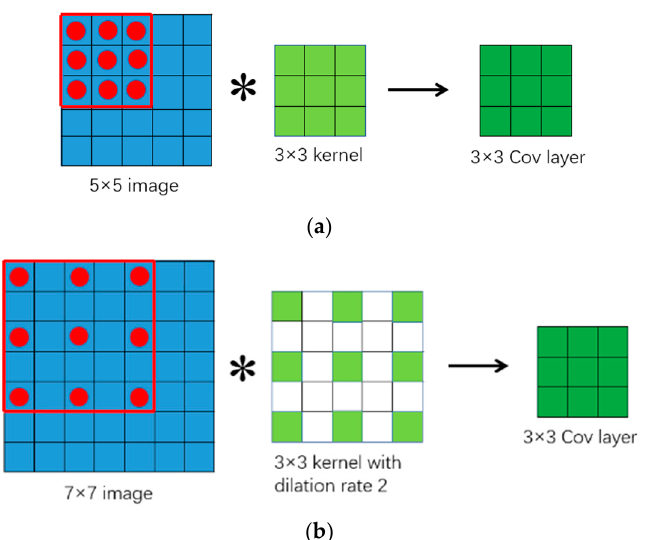
Figure 1. Illustrations of ( a ) convolution and ( b ) atrous convolution.